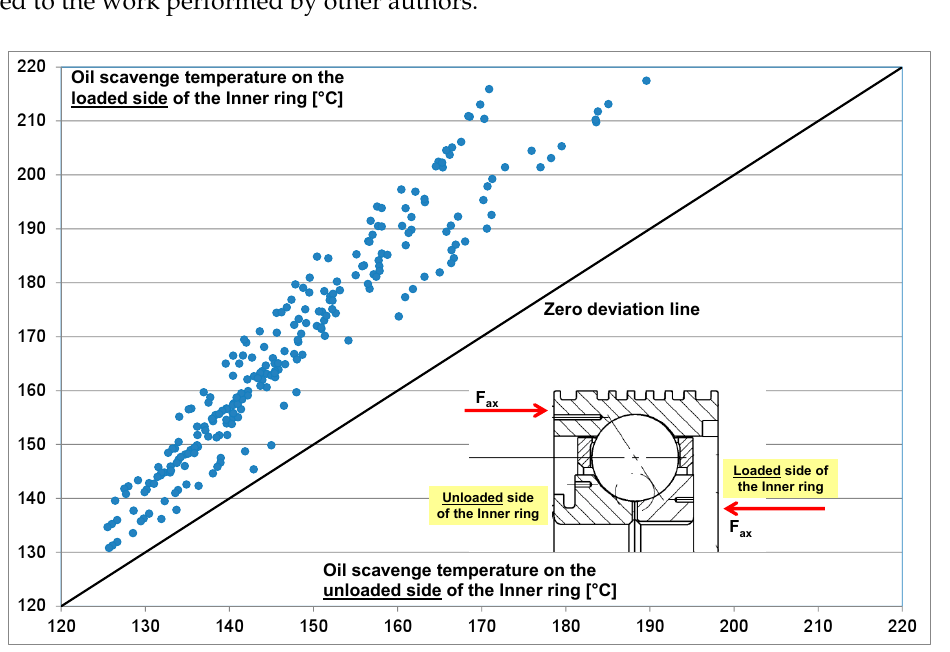
Figure 5. The oil scavenge temperatures to the loaded and to the unloaded side of the hybrid bearing. If both were equal, the points should be along the zero deviation line.